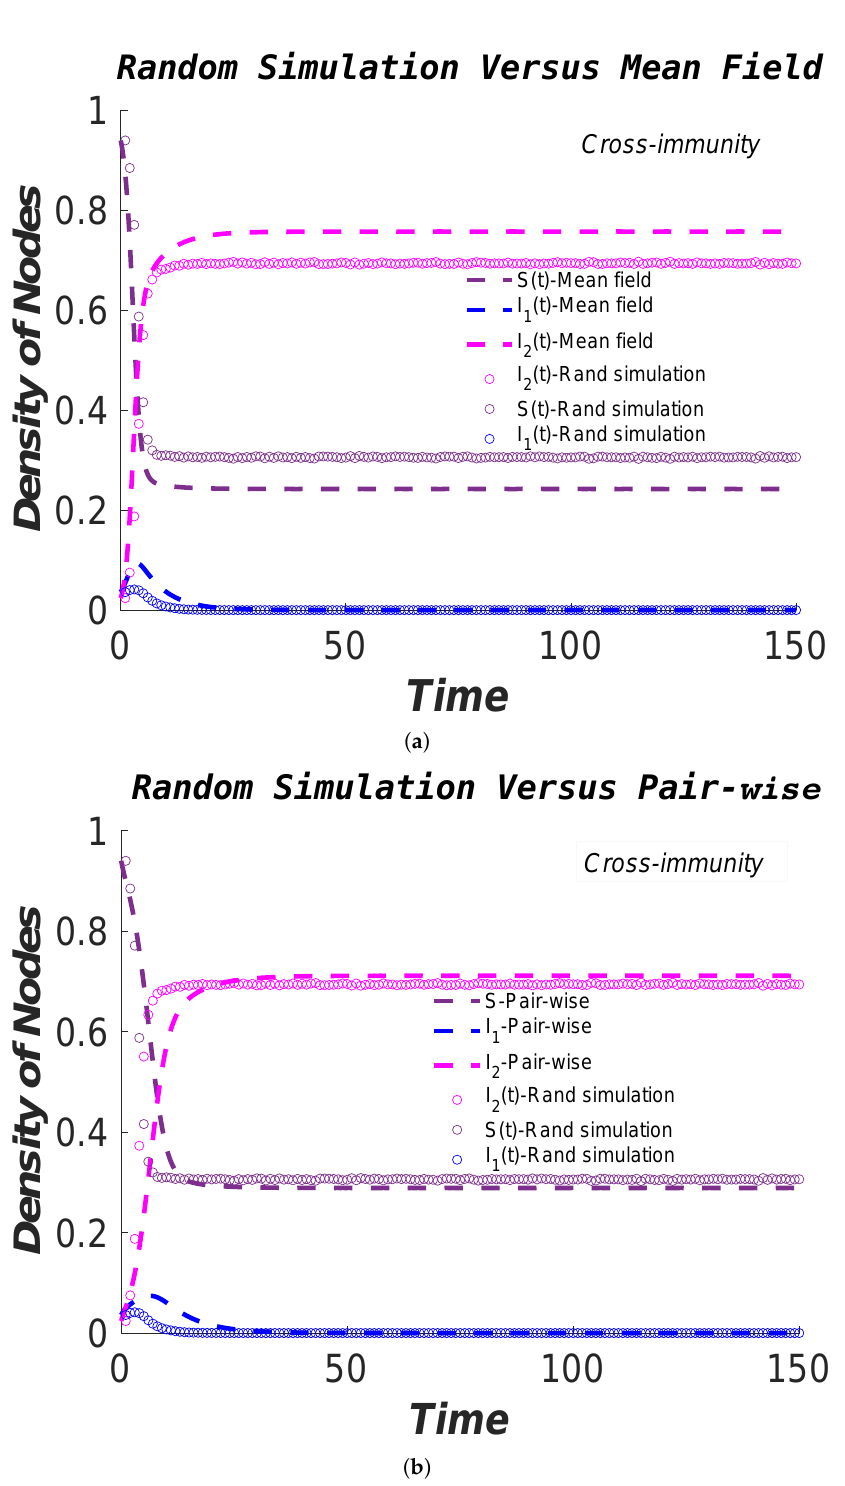
Figure 8. Comparison of random simulation with mean-field and pairwise models for cross-immunity: γ 1 = 0.4, γ 2 = 0.3, λ 1 = 0.2, and λ 2 = 0.75. ( a ) Comparison of random simulation and mean-field models. ( b ) Comparison of random simulation and pairwise